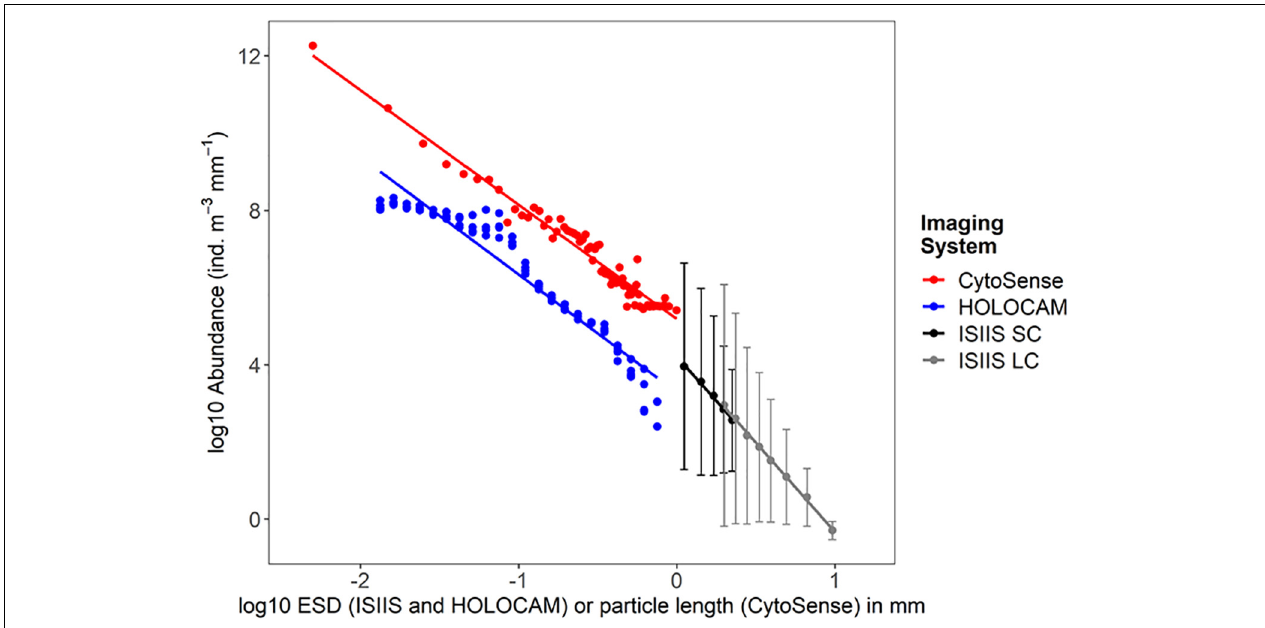
FIGURE 7 | Particle size vs. abundance as detected by the CytoSense (for hydrographic stations visited on May 01, 2018 and afterward), 4 vertical profiles from the HOLOCAM, and the two cameras (SC, small camera; LC, large camera) from the ISIIS. Errorbars on the ISIIS data indicate the standard deviation of the particle concentrations from the different size classes.